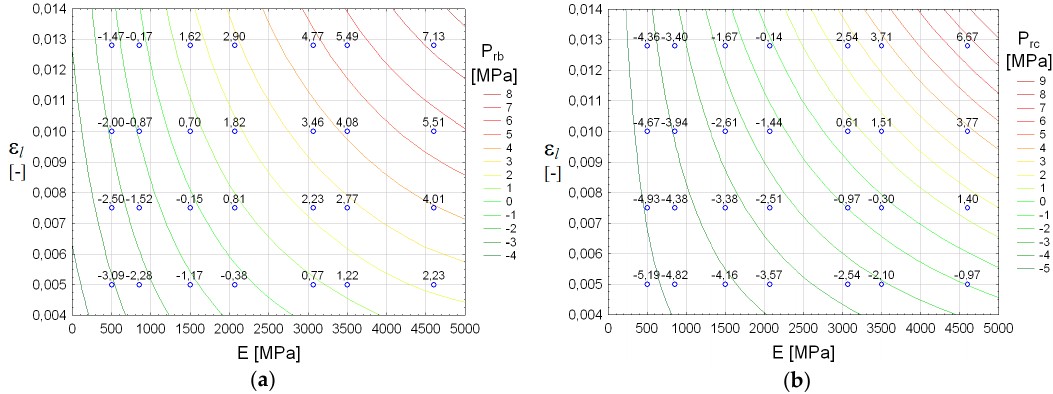
Figure 15. Maps of: ( a ) the rebound pressure P rb ; and ( b ) the recovery pressure P rc , as correlated with E and ε l for the Mannville Group basin, Lower Cretaceous, Western Canada.